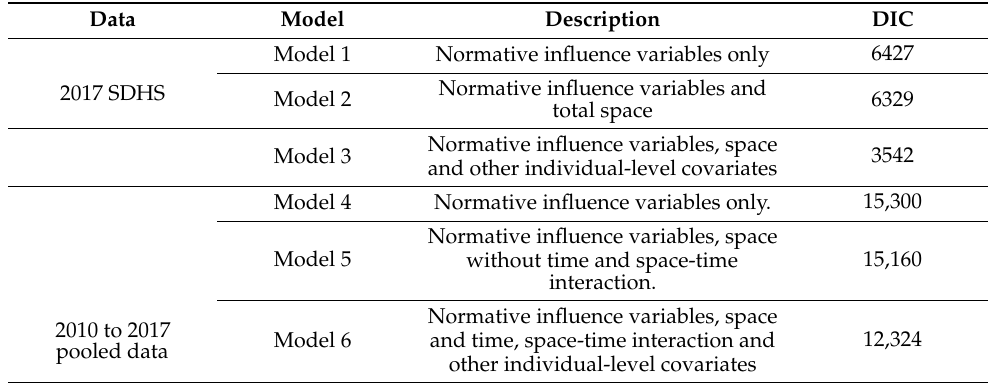
Table 2. Deviance information criterion (DIC) from the three models fitted on the 2017 Senegal Demographic and Health Survey (SDHS) data and the combined 2010 to 2017 data.